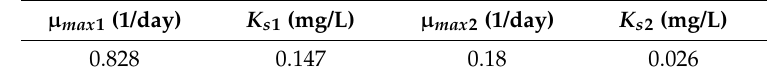
Table 2. Kinetics parameters of model #2.